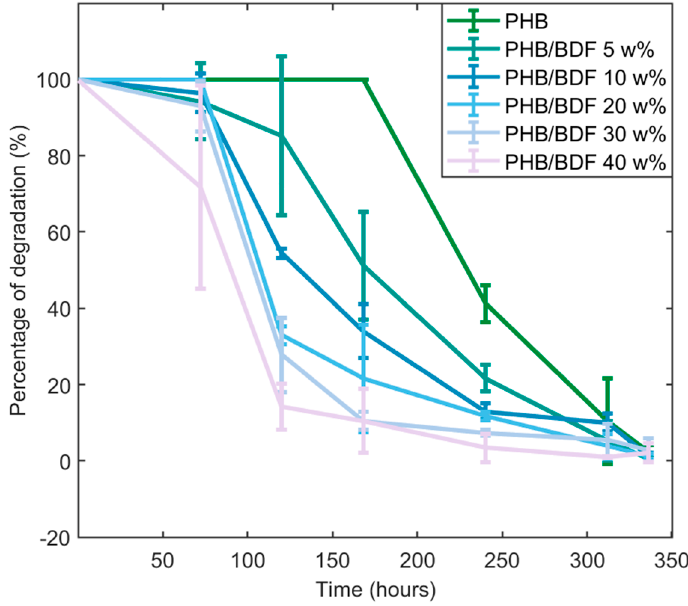
Figure 8. Degradation kinetics of each powder of PHB/BDF blends obtained from image analysis.